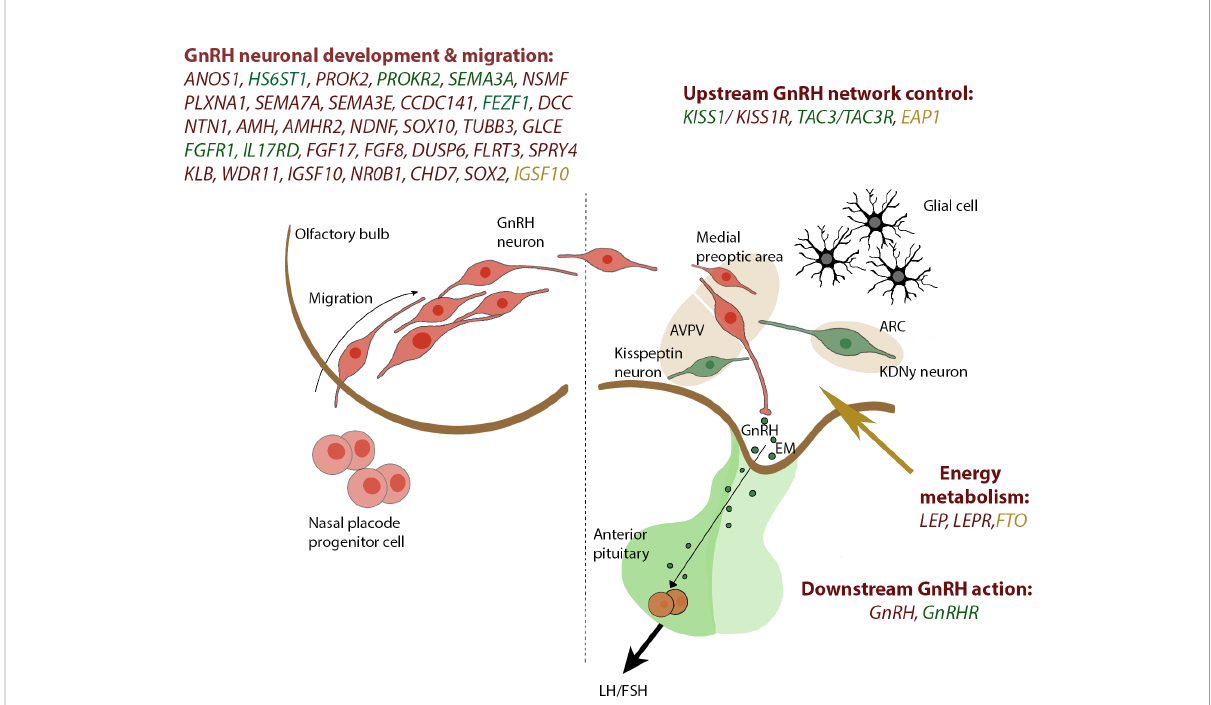
FIGURE 1 Genes reported in CHH and SLDP are related to GnRH development and GnRH function. The drawing on the left panel shows the migration of the GnRH neurons from the olfactory placode and into the hypothalamus which occurs within the fi rst 10 to 12 weeks of rodent life. In the right panel, a concise view of our current understanding of the KISS1 neuronal networks governing GnRH secretion is depicted. Genes associated with CHH are depicted in red, shared genes between CHH and SLDP are depicted in green whereas genes related to SLDP are marked in orange. GnRH, gonadotropin-releasing hormone; KNDy, Kiss1/NKB/Dyn neuron; ARC, arcuate nucleus; AVPV, anteroventral periventricular nucleus; EM, median